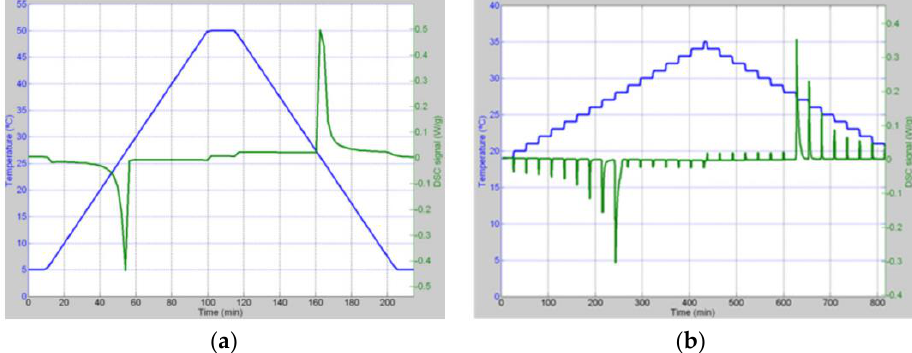
Figure 4. Modes of heating and the corresponding DSC signals: ( a ) dynamic mode and ( b ) step mode after